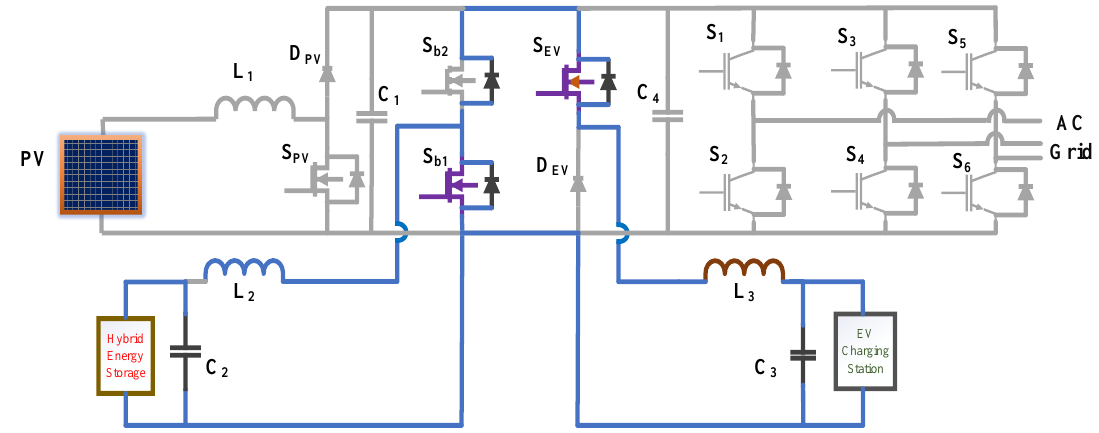
Figure 7. Power flow from HESS to EV Charging station.